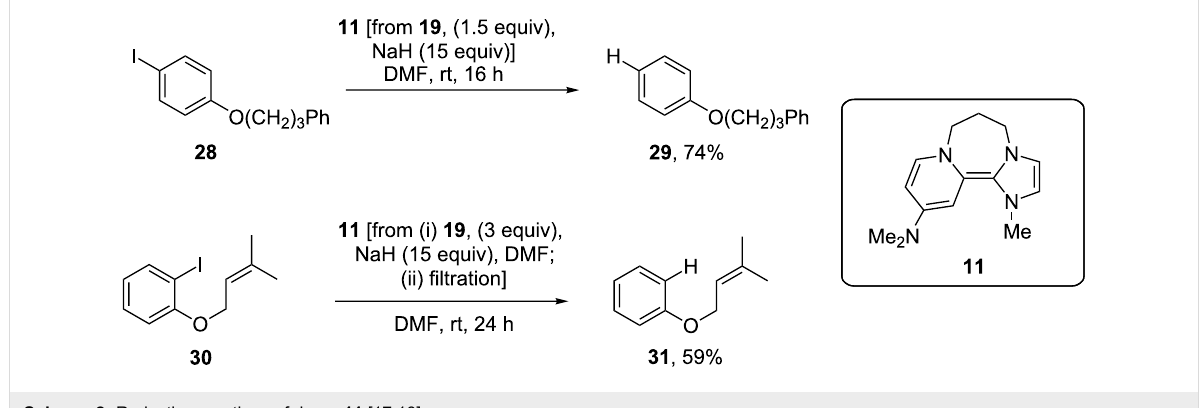
Scheme 2: Reductive reactions of donor 11 [17,18].